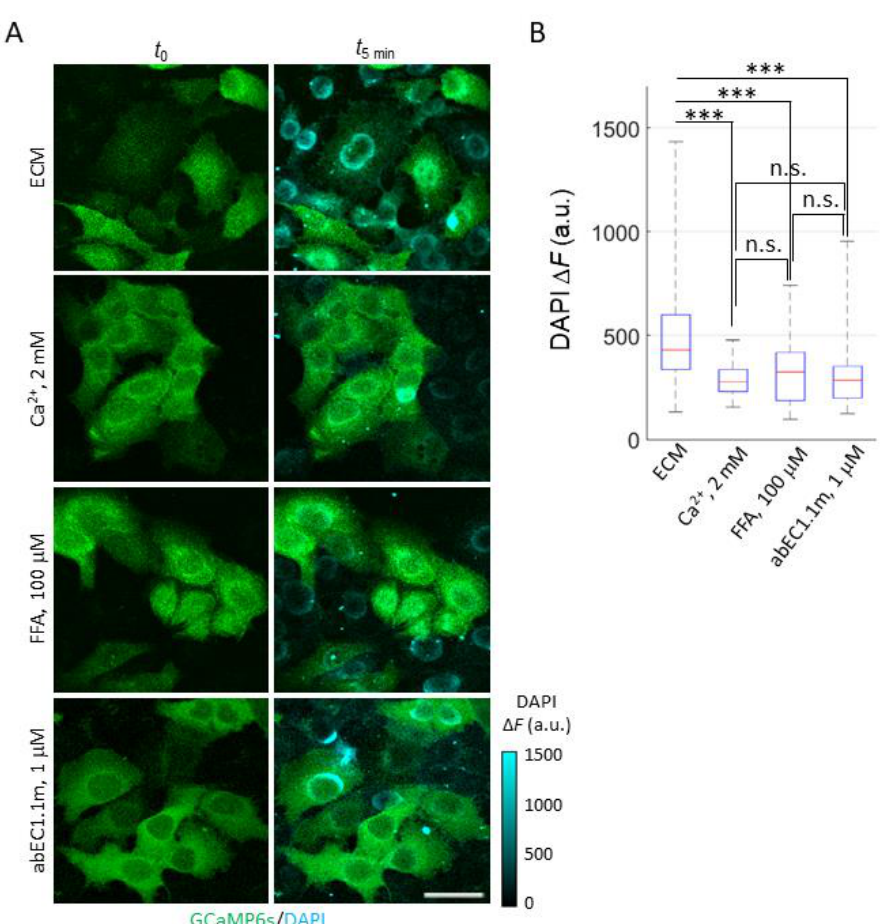
Figure 3. DAPI uptake in HaCaT-Cx26-GCaMP6s cells. ( A ) Fluorescence images were acquired using the two-photon microscope described in [79] before ( t 0 ) and after 5 min of incubation ( t 5 min ) with DAPI (5 µM) in one of the following conditions (from top to bottom): ECM, ECM plus 2 mM Ca 2+ , ECM plus 100 µM FFA (denoted as FFA) or ECM plus 1 µM abEC1.1m (denoted as abEC1.1m). GCaMP6s signal (green) is shown as absolute fluorescence intensity ( F ). DAPI signal (cyan) is shown as Δ 𝐹 = 𝐹 5 min − 𝐹 0 . Scale bar: 40 µm. ( B ) Box plots of single cell Δ 𝐹 distributions for DAPI uptake experiments described in ( A ); for each condition, DAPI uptake was measured in 45 ≤ n ≤ 80 cells. Red horizontal bars represent the median. Statistical significance was calculated using the Dunn– Sidak post hoc test for pairwise comparisons after the Kruskal – Wallis ’ test; ***, P < 0.001; and n.s., not significant.